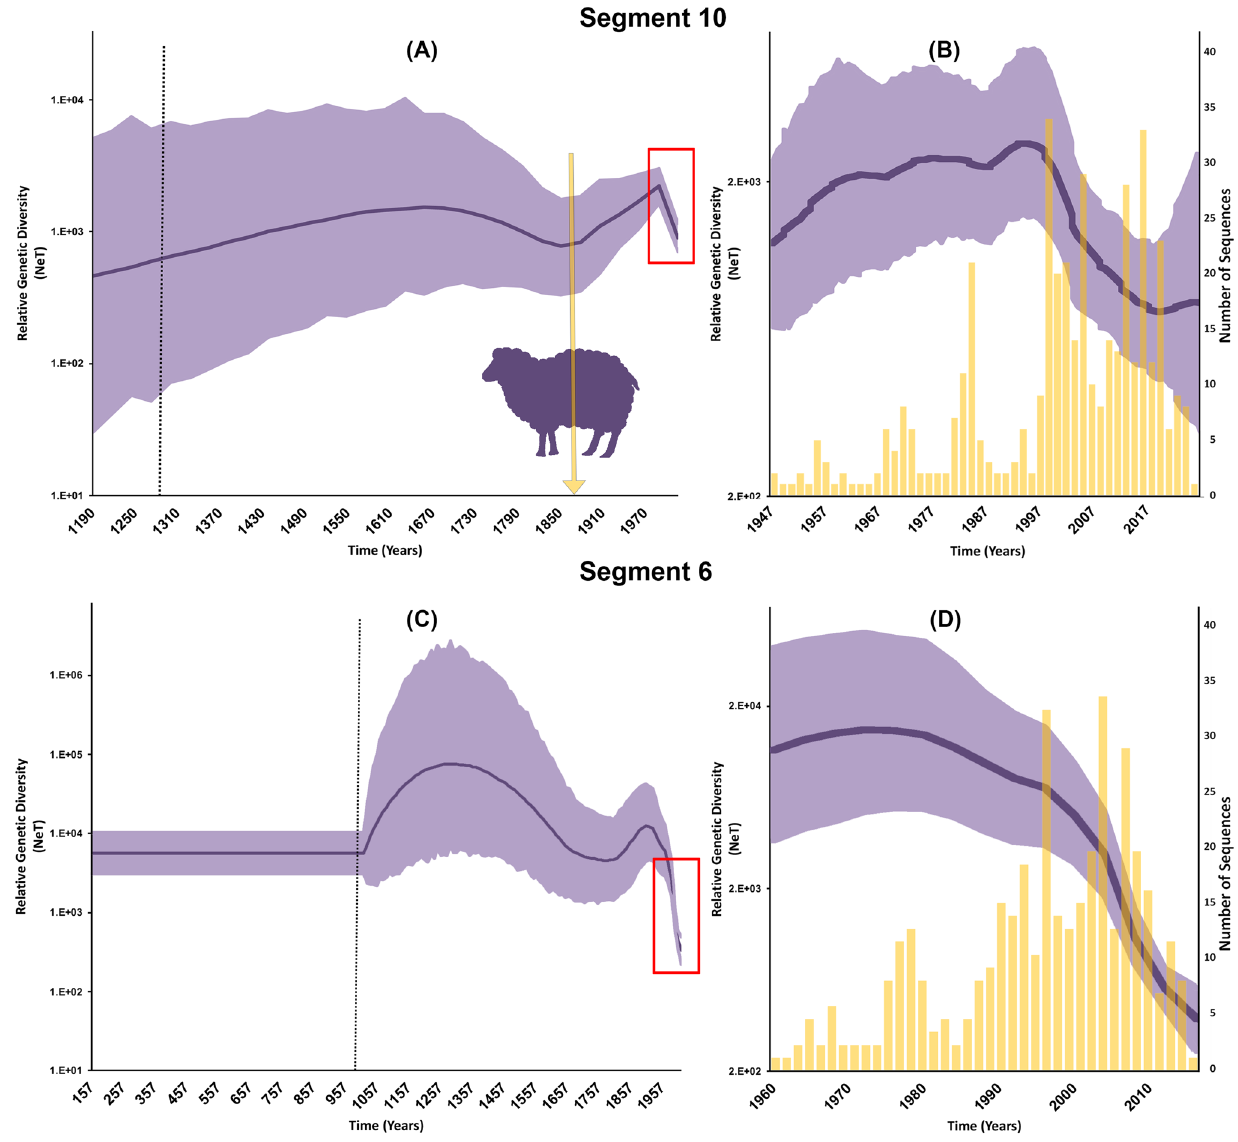
Figure 1. Bayesian Skygrid (BSg) plots of the relative genetic diversity through time segments 10 and 6 sequences of Bluetongue virus between 1958 and 2016. The posterior median estimate is indicated by the dark purple line, and the light purple shaded areas correspond to the 95% high posterior density (HPD). ( A , C ) Vertical dotted line represents the estimated time at which the relative genetic diversity transitioned from a slow to a fast growth rates, the red rectangle highlights the genetic diversity of the present sequence data. The yellow arrow indicates the time when Merino sheep farming was introduced from Europe to Africa. ( B , D ) BSg plot is a detailed magnification for genetic diversity of the sequences included in the BEAST analyses, and the yellow bars indicate their temporal distribution. ( A , B ) Indicate segment 10. ( C , D ) Indicate segment